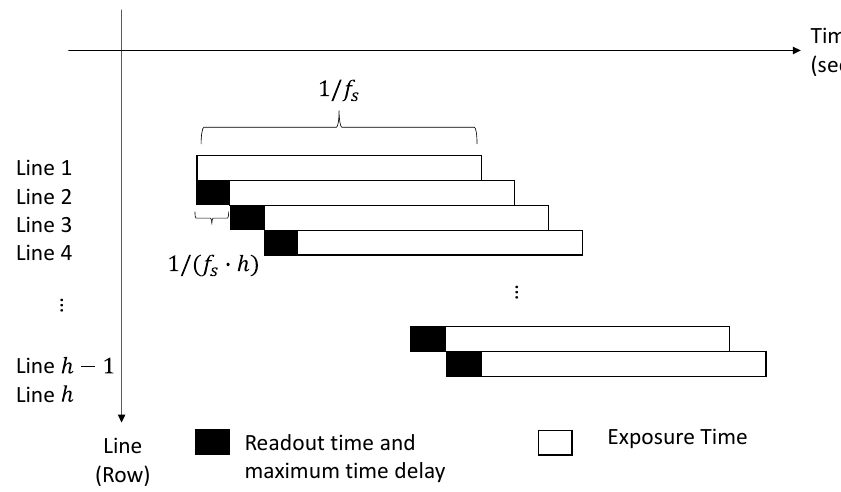
Figure 3. Readout time and exposure time in rolling shutter in single image frame.